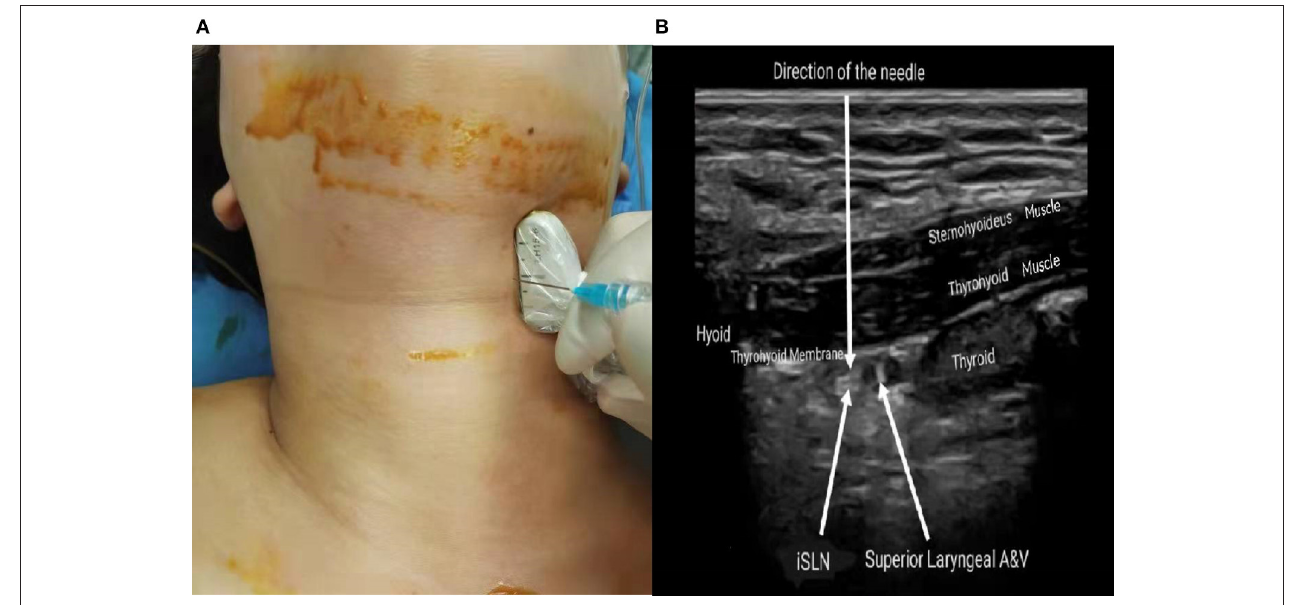
FIGURE 2 | (A) Location of high frequency puncture probe and needle. (B) Ultrasound image of iSLNB.